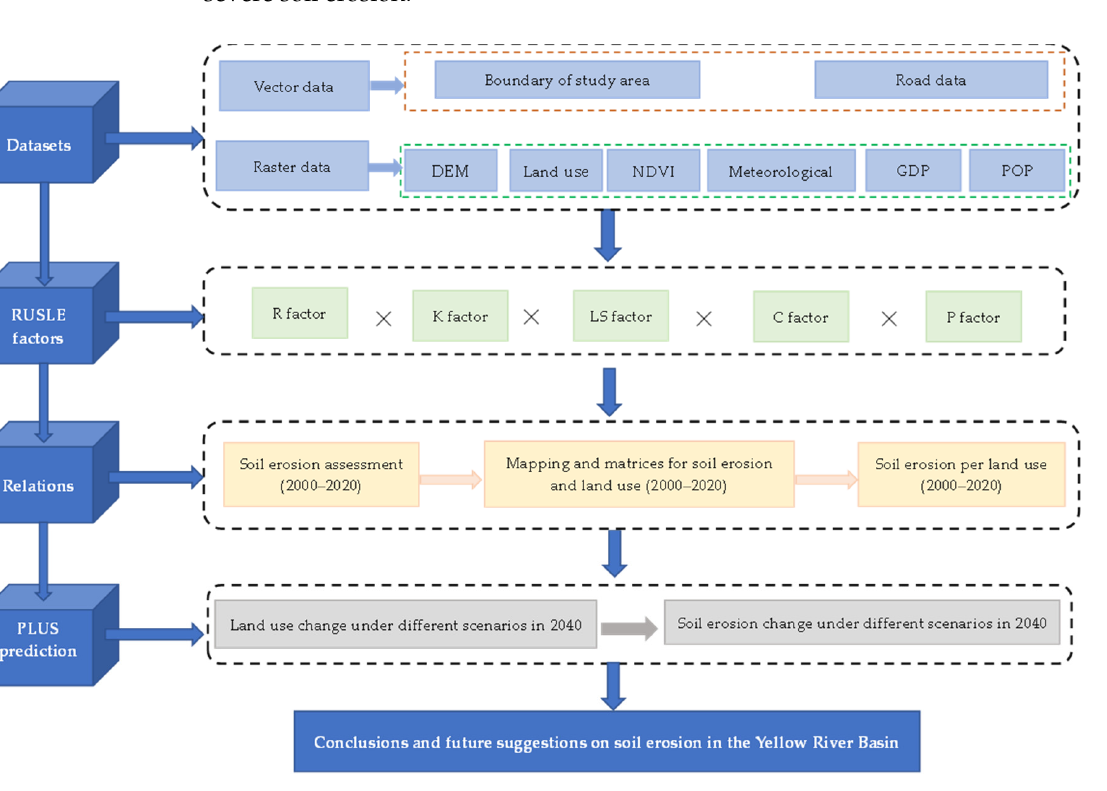
Figure 1. Research